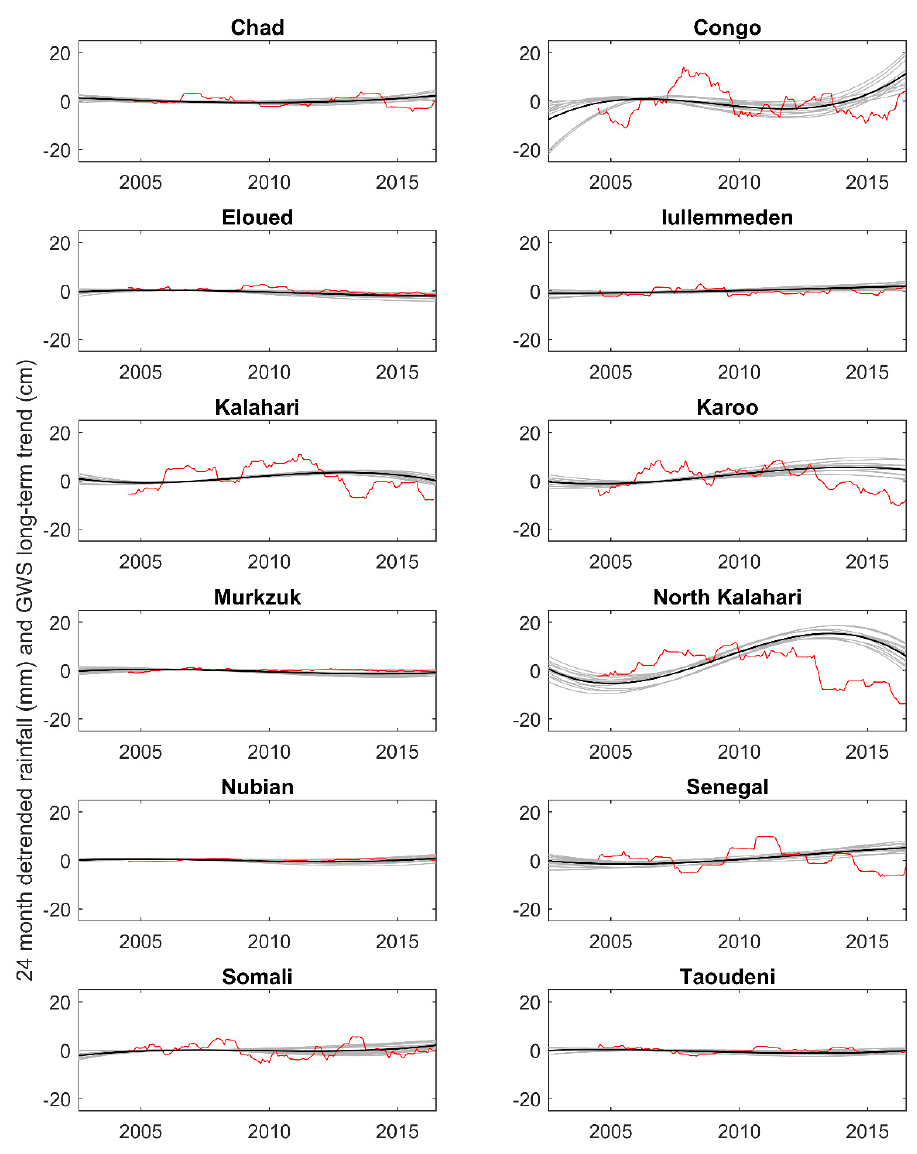
Figure 6. Long-term patterns in estimated GWS anomaly changes for each of major aquifer basins in Africa. The solid black line shows the ensemble GWS changes, with the grey lines denoting the surrounding range of TWS changes from the different products. Mean de-seasonalised monthly rainfall averaged over 24 months (mm) is shown in red.